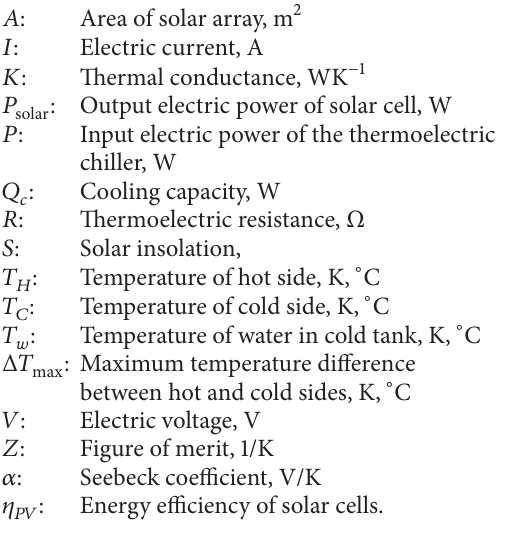
Figure of merit, 1/K 𝛼 : Seebeck coefficient, V/K 𝜂 𝑃𝑉 : Energy efficiency of solar